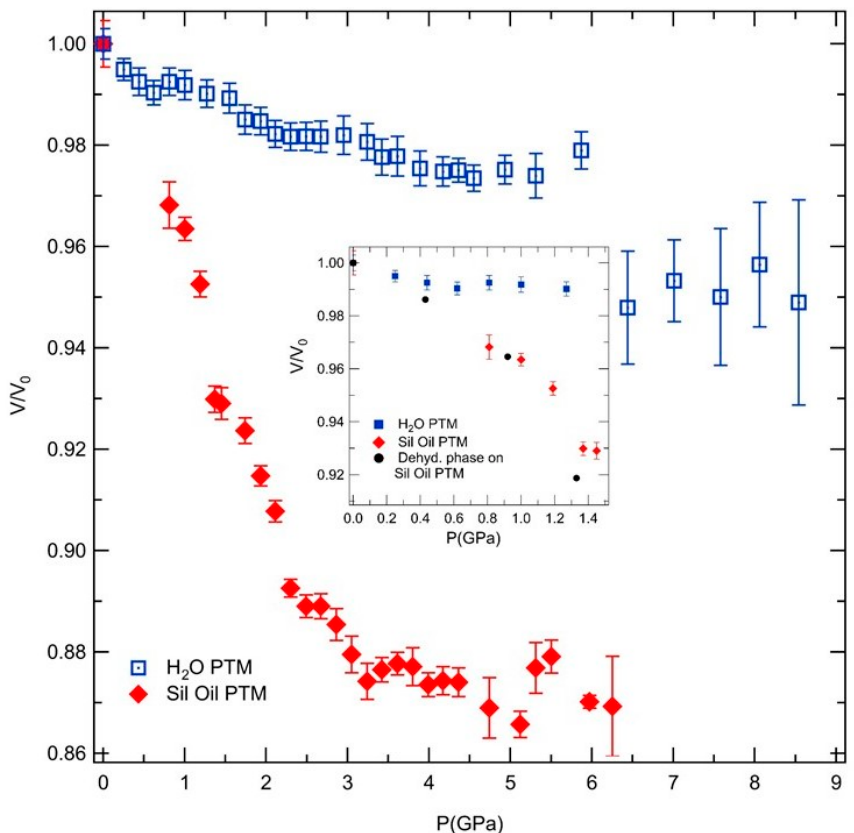
Figure 4. Relative volume as a function of pressure in silicone oil (red) and in H 2 O (blue) PTM. Insert: behavior on the low pressure range and (black) comparison with its dehydrated phase (reproduced from Ref. [16]).